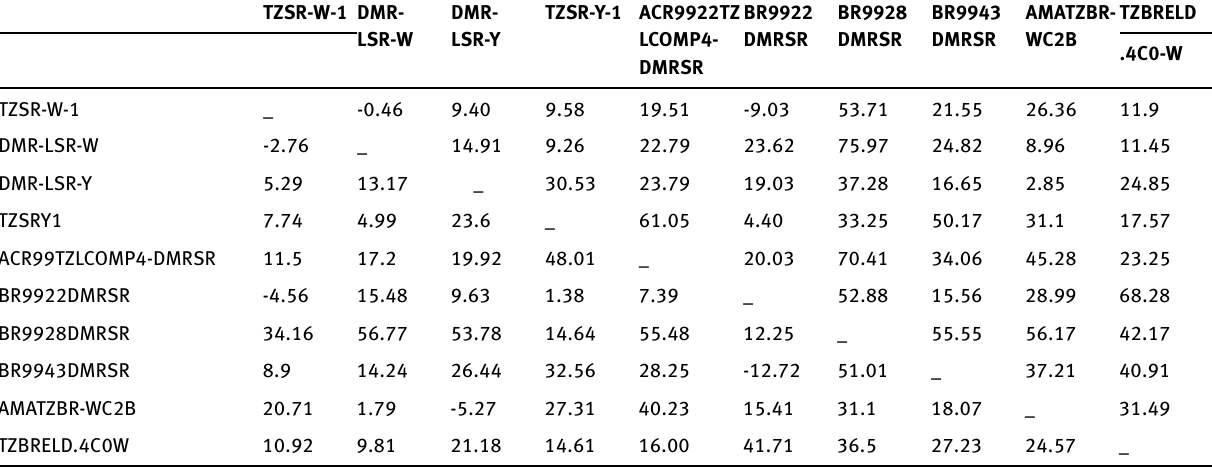
Table 3: Mid-parent heterosis (upper diagonal) and high-parent heterosis (lower diagonal) for maize grain yield under low-N conditions at Mokwa and Zaria,